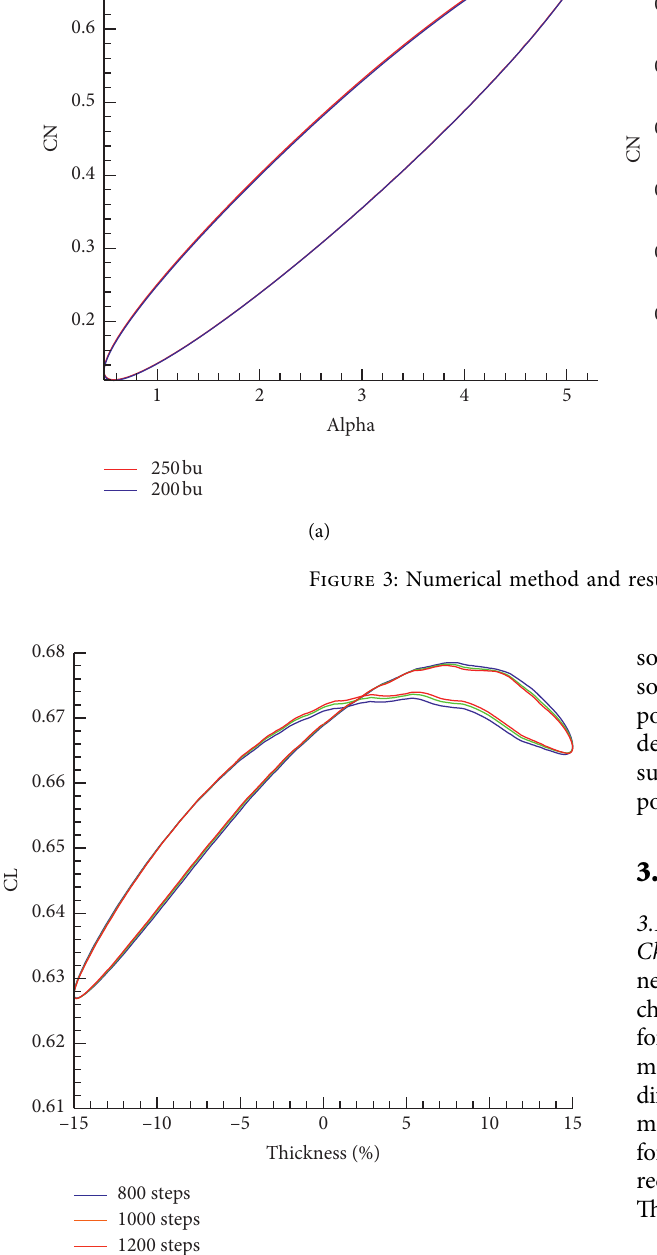
Figure 4: Comparison of C L in different time step sizes ( M � 0.74, α � 2 ° , and F � 1Hz).